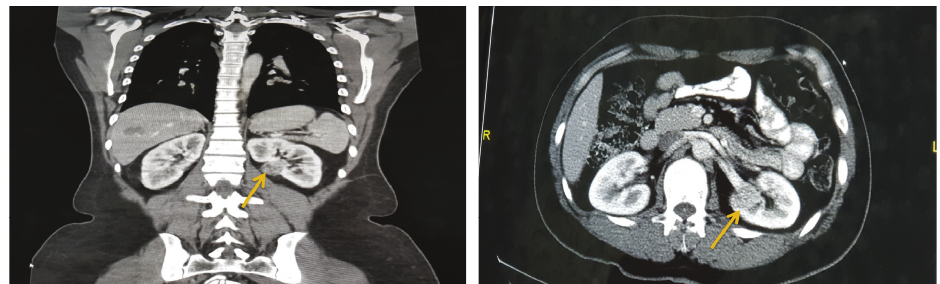
Figure 1: Axial and coronal view of abdominal CTscan showed a well-defined hypodense focal lesion originally from left kidney near hilum region with clue sign. The renal lesion showed inhomogeneous enhancement in the arterial phase with partial wash out in delayed phase, and it measured 2.6 cm ×